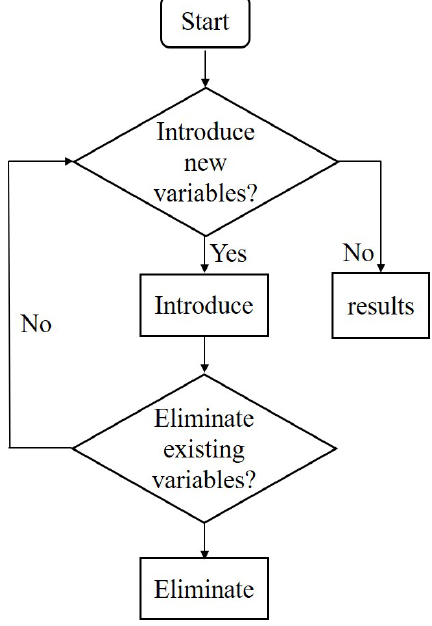
Figure 8. Schematic diagram of the stepwise regression